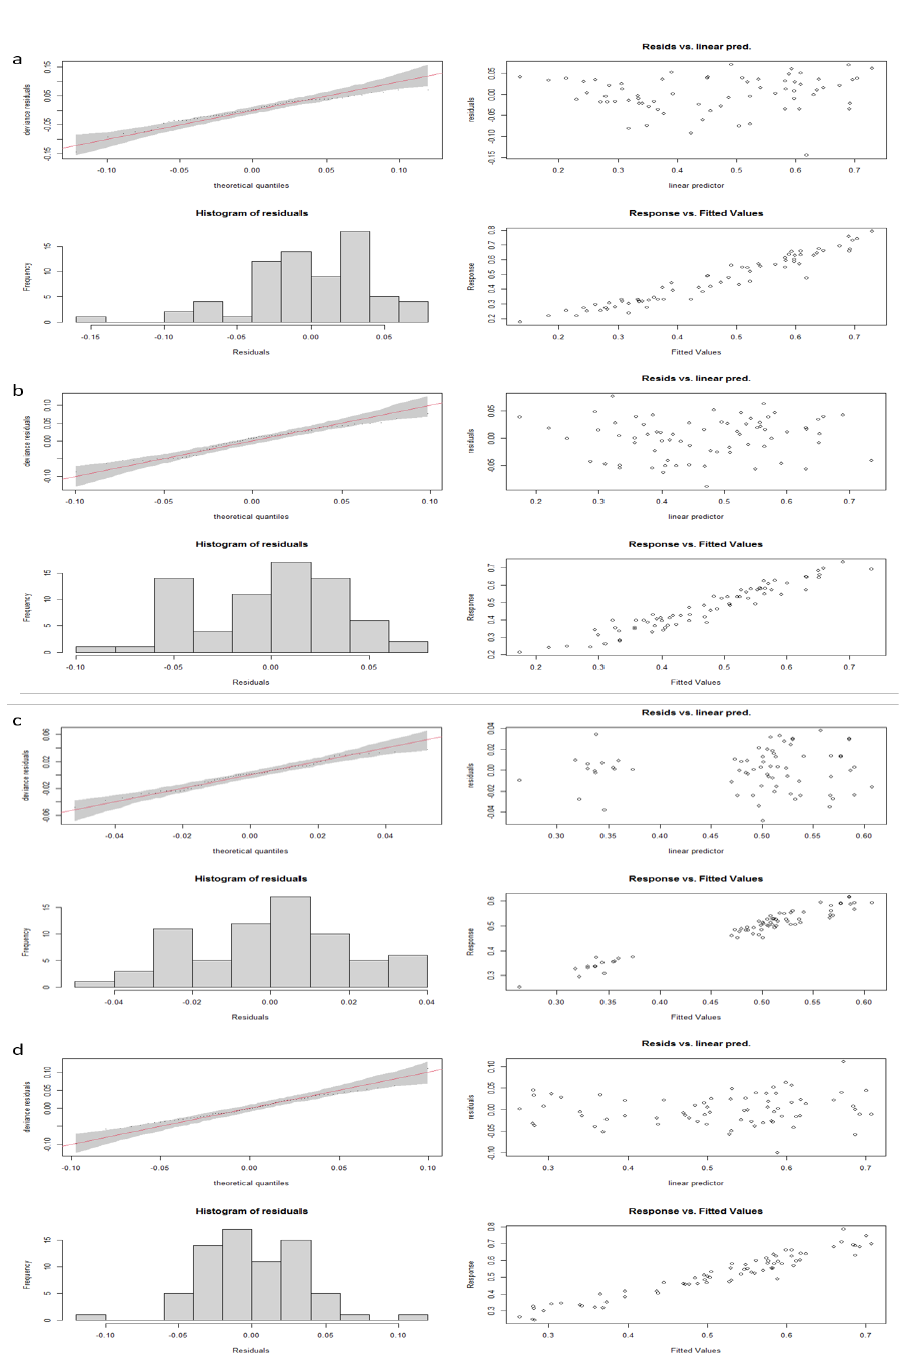
Figure A1. Diagnostic plots of the GAM models adjusted to the production (peak NDVI) of the four main vegetation types consumed by wild and domestic ungulates at the study area (Doñana National Park). Model for saltmarsh ( a ), bulrush marsh ( b ), shrubland ( c ), and grassland ( d ).